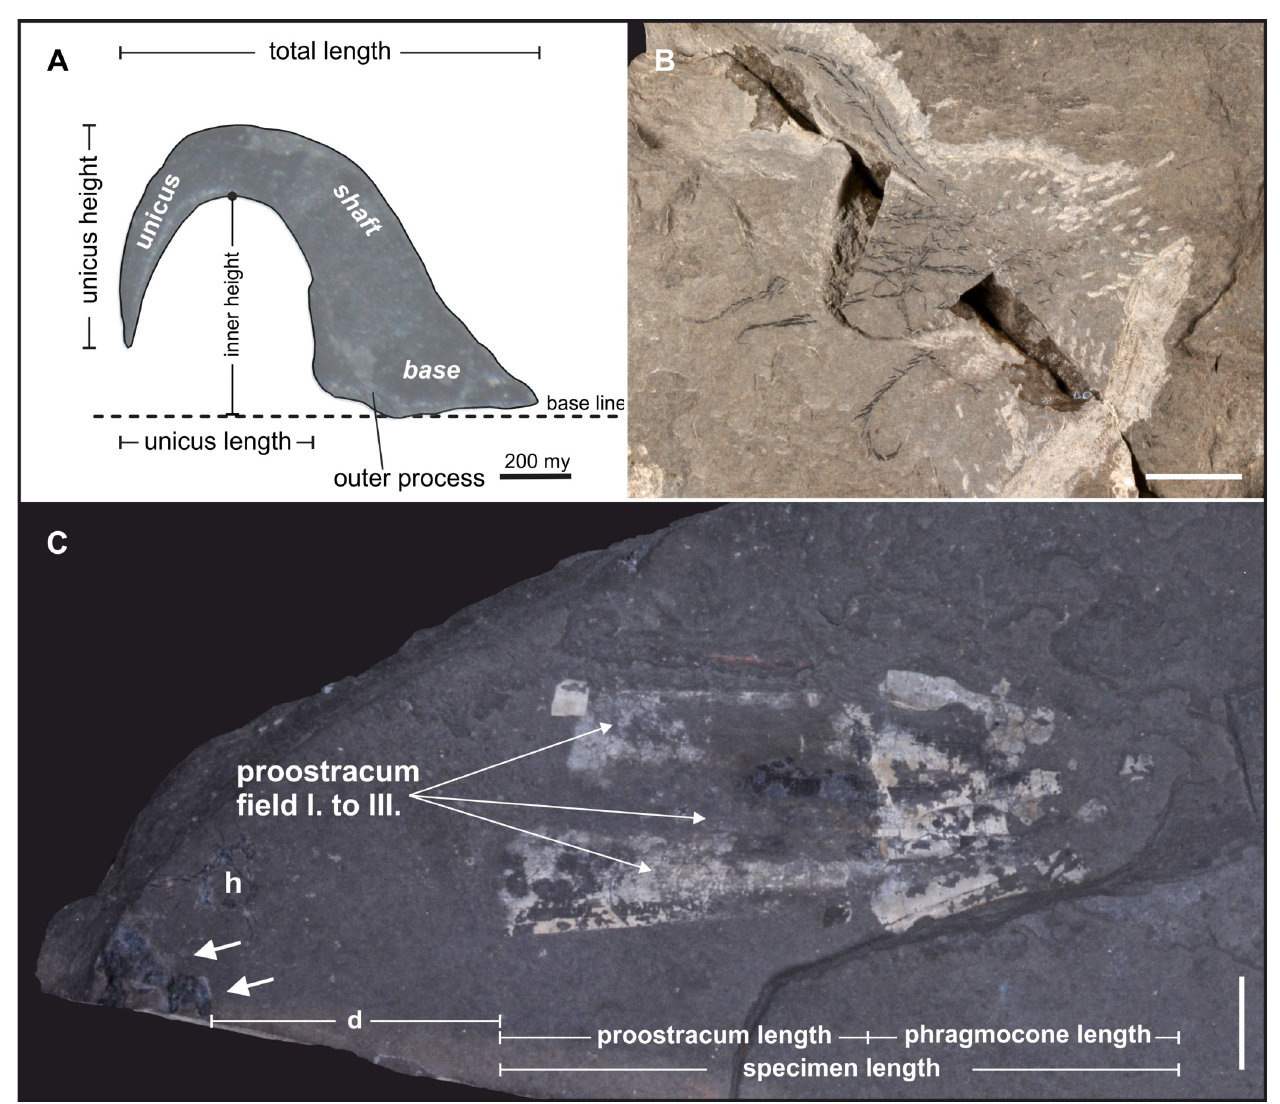
Fig 2. Belemnoid fossils from the late Triassic Konservat-Lagerstätte Polzberg near Lunz am See. (A) Hook morphology in phragmoteuthid arm crowns. (B) Semi in situ preserved arm crown. Each arm comprises two rows of hook armory. Terms adapted from [30]. (C) Belemnoid fossil remains, assigned to the taxon Phragmoteuthis bisinuata with its characteristic fan-shaped three-parted proostracum. White arrows pointing to position of carbonized structure.